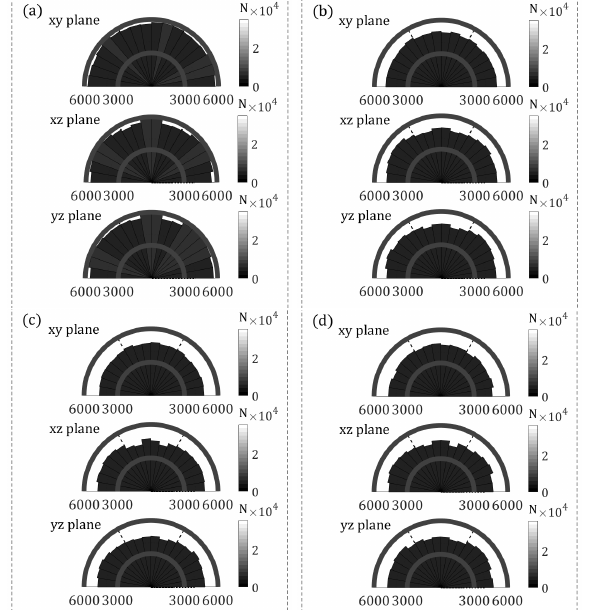
= Figure 6. Normal force distributions of the RM samples at 0 = 1000 kPa , with projections onto the xy, xz and yz planes, p (cid:48) 0 respectively: (a) µ p = 0 . 05; (b) µ p = 0 . 25; (c) µ p = 0 . 50; and (d) µ p = 0 . 75.